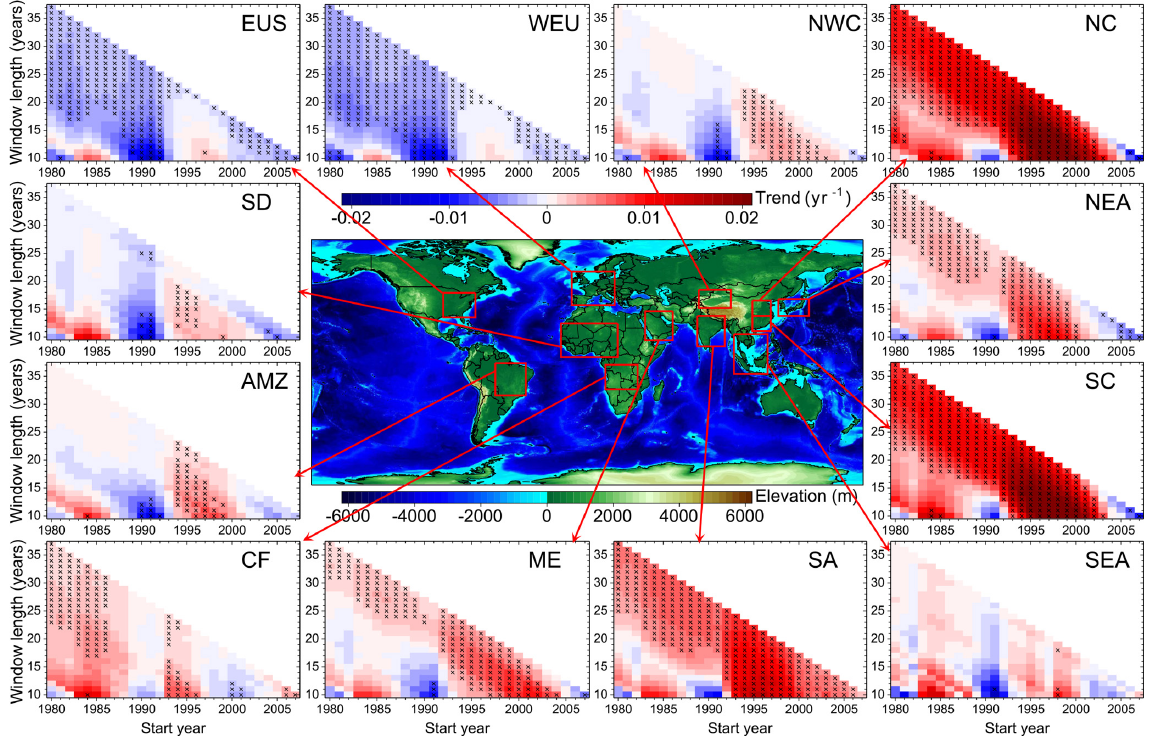
Figure 9. Sliding-window trend analyses of the annual mean MERRA-2 AOD from 1980 to 2016 over the 12 ROIs (see Fig. 1 for names and locations of regions), with at least 10 years used to calculate trends. The x axis and y axis indicate the start year and the length of the time series to calculate the trend, respectively. The colors of the rectangles represent the intensity of the trend (units: yr − 1 ) and those with black “x” signs indicate linear trends above the 95% significance